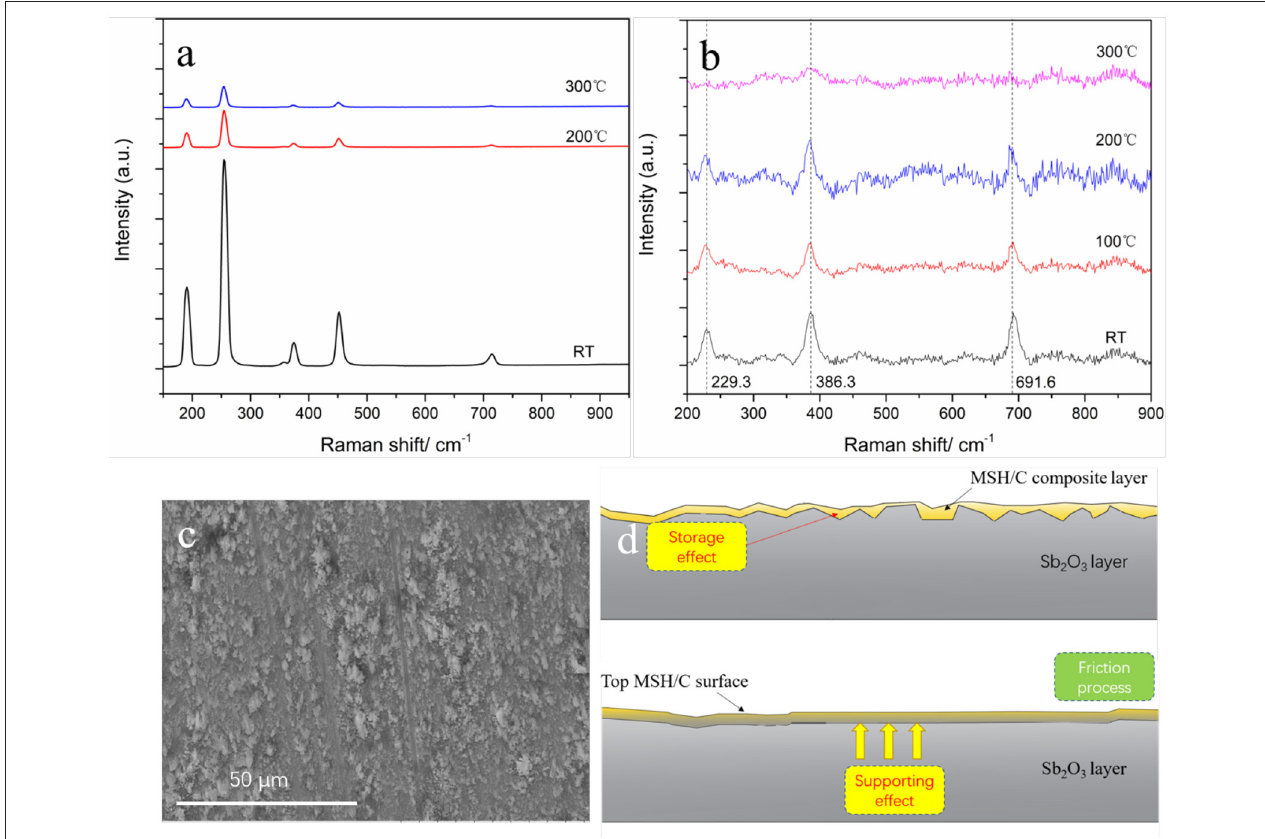
FIGURE 8 | Raman spectrums of Sb 2 O 3 (a) and MSH/C (b) under different temperatures (Excitation wavelength of 532nm) used for the tribological analysis, (c) the rough surface prepared by burnish process, and (d) the synergistic effect between the MSH/C layer and Sb 2 O 3 layer.